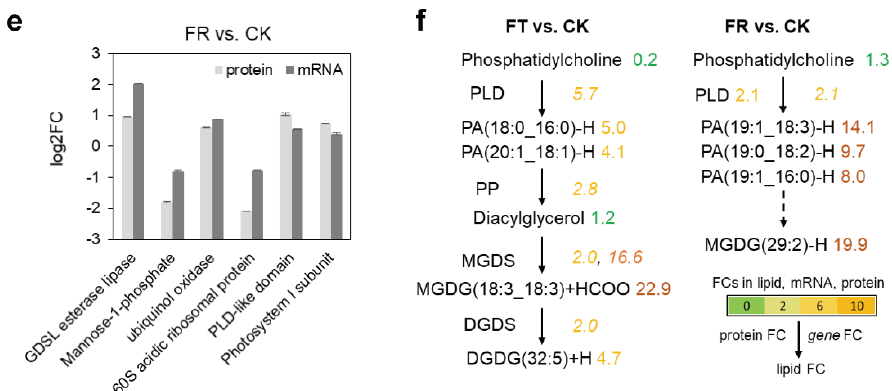
Figure 4. Integrated analysis of multi-omics during freezing stress. ( a ) Scatter plot showing the relationship between changes in protein and mRNA abundances in FT vs. CK. ( b ) Scatter plot showing the relationship between changes in protein and mRNA abundances in FT vs. CK. The colored points indicate significant upregulation or downregulation of protein and mRNA levels. ( c ) KEGG enrichment analysis of mRNAs and encoding proteins based on ( a , b ). ( d ) Enrichment of mRNAs and encoding proteins in FT vs. CK. ( e ) Enrichment of mRNAs and encoding proteins in FR vs. CK. ( f ) Simplified lipid biosynthesis flow based on multi-omics. FCs in lipid, mRNA (underlined on the right), and protein levels (left) are listed and highlighted in different colors according to FC values. The ion characteristic fragments and chromatogram of lipids are shown in Figure